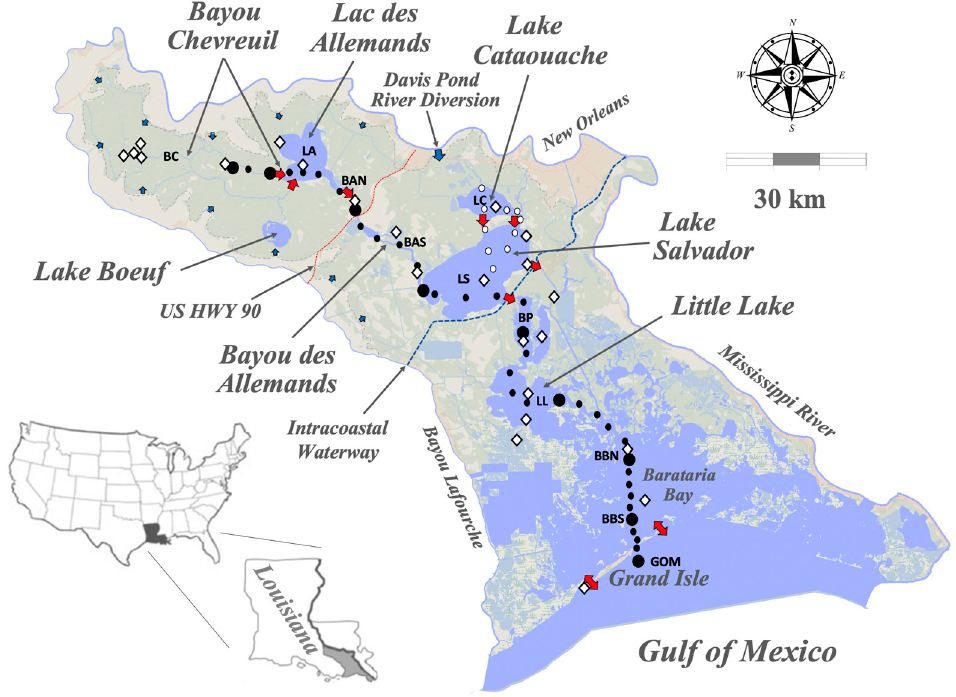
Figure 1. Map showing major features of Barataria Basin (blue—water, green—wetlands, tan—uplands. Symbols represent sampling stations of two transect studies of water parameters in the basin. White diamonds are from [16,24] for 1977–1978 (see Figure S1 in supplemental material). Circles are from [23] for transects from 1995 to 2016 (see Figure S2 in supplemental material). Dark circles are stations along the main drainage axis of the basin (larger circles are every fifth station). White circles are stations added in 2005 to capture the influence of the Davis Pond river diversion, which began operation in 2002. Dark arrows along the periphery of the upper-basin indicate agricultural runo ff . Red arrows show the main pathways of water flow in the basin. Bayou des Allemands is the single outlet from the upper-basin (above US HWY 90), and there are two outlets from the mid-basin (between highway 90 and the Intracoastal Waterway) to the lower-basin. Water also flows from Lake Cataouatche to Lake Salvador. Water is exchanged with the Gulf of Mexico through several deep passes. Letters indicate station groupings used for analysis of water quality parameters: BC—Bayou